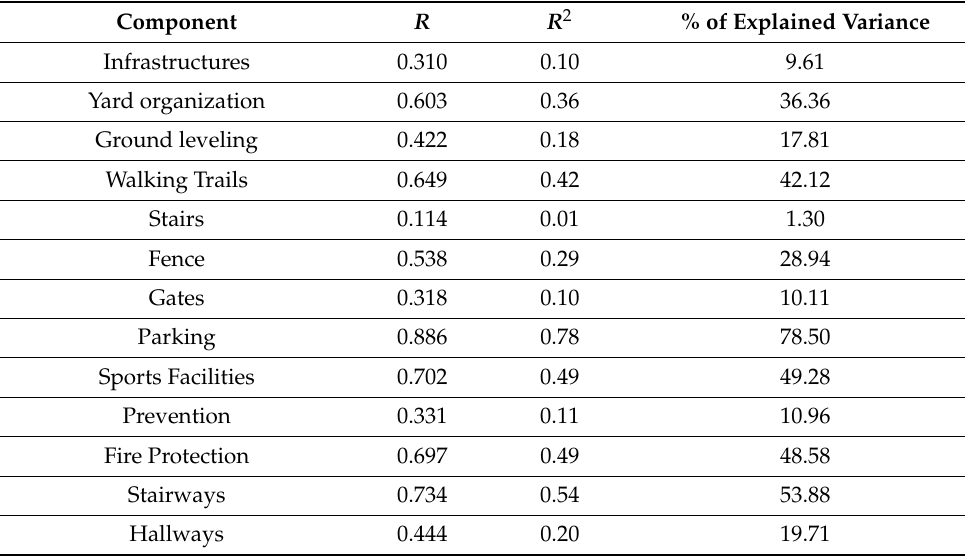
Figure 8. Mean Safety Indicators Vs. Mean Maintenance Indicators—Educational Institutions. Table 5. Pearson coefficient for the facilities’ components and systems.